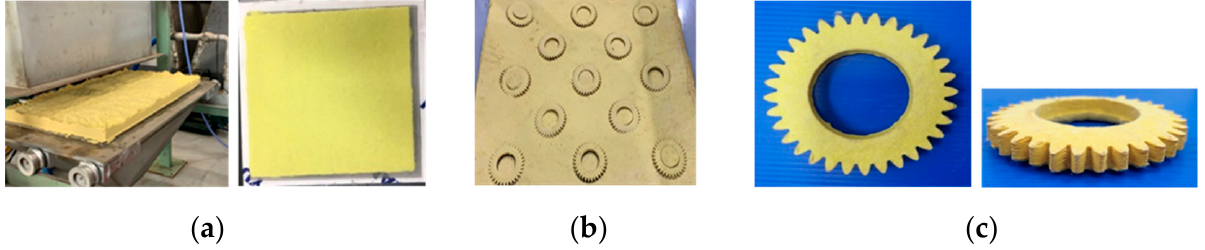
Figure 1. ( a ) WLF sheet manufacturing; ( b ) Cutting process; and ( c ) WLF preform manufacturing. Table 1. Dimensions of the WLF preform. Type of Profile